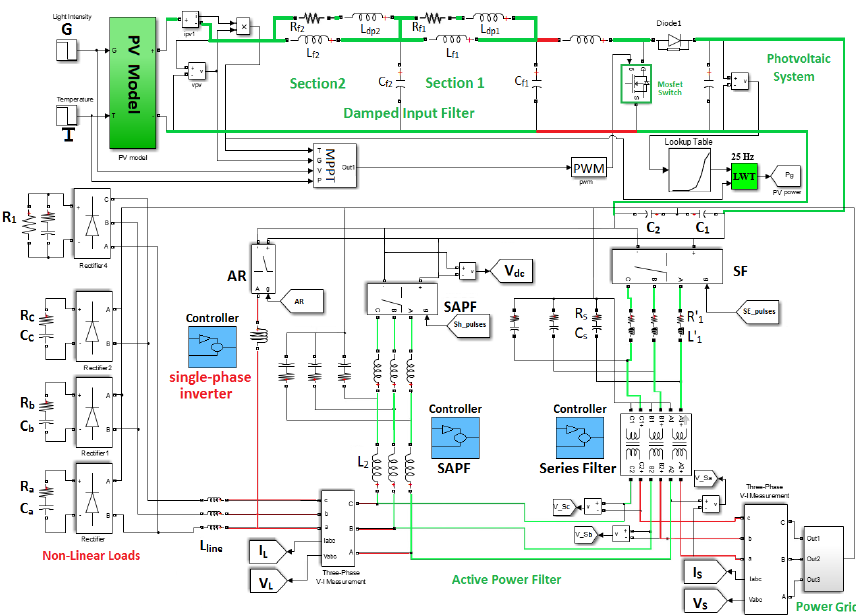
Figure 6. Simulation of proposed damped input filer within a grid-integrated PV system via an active filter. Table 1. Parameters of single–phase and three–phase loads in Figure 6.